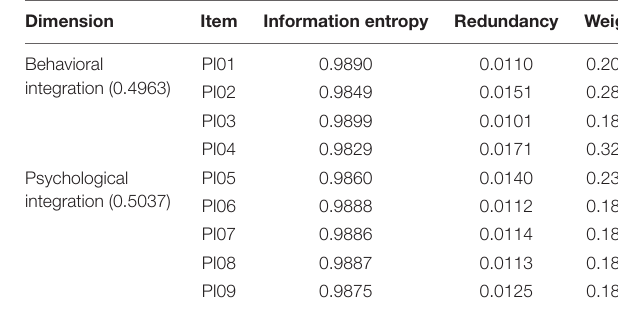
TABLE 3 | Summary of weight calculation results of various indicators of migrant workers’ urban